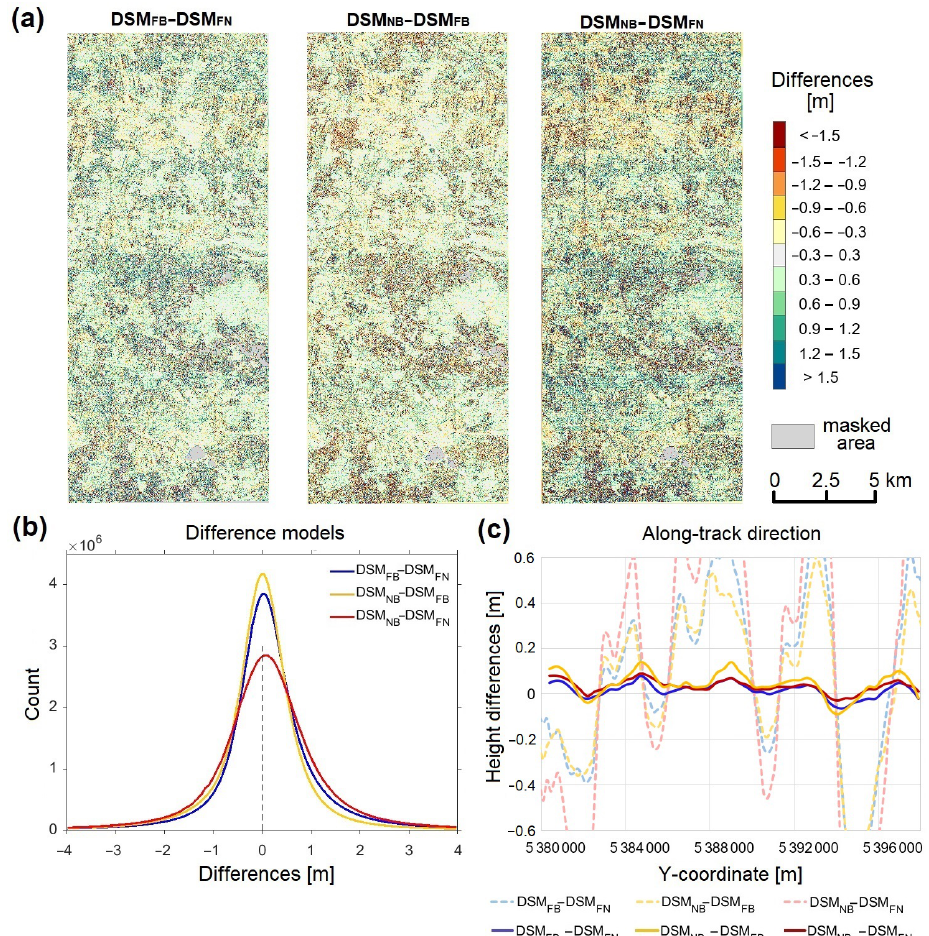
Figure 20. Differences between Pléiades pairwise DSMs after image geometry correction: ( a ) Color- coded height differences. ( b ) Frequency distribution of height discrepancies. ( c ) Section profile in the along-track direction with Z elevation differences before (square-dot lines) and after (solid lines) image geometry correction (to be compared with Figure